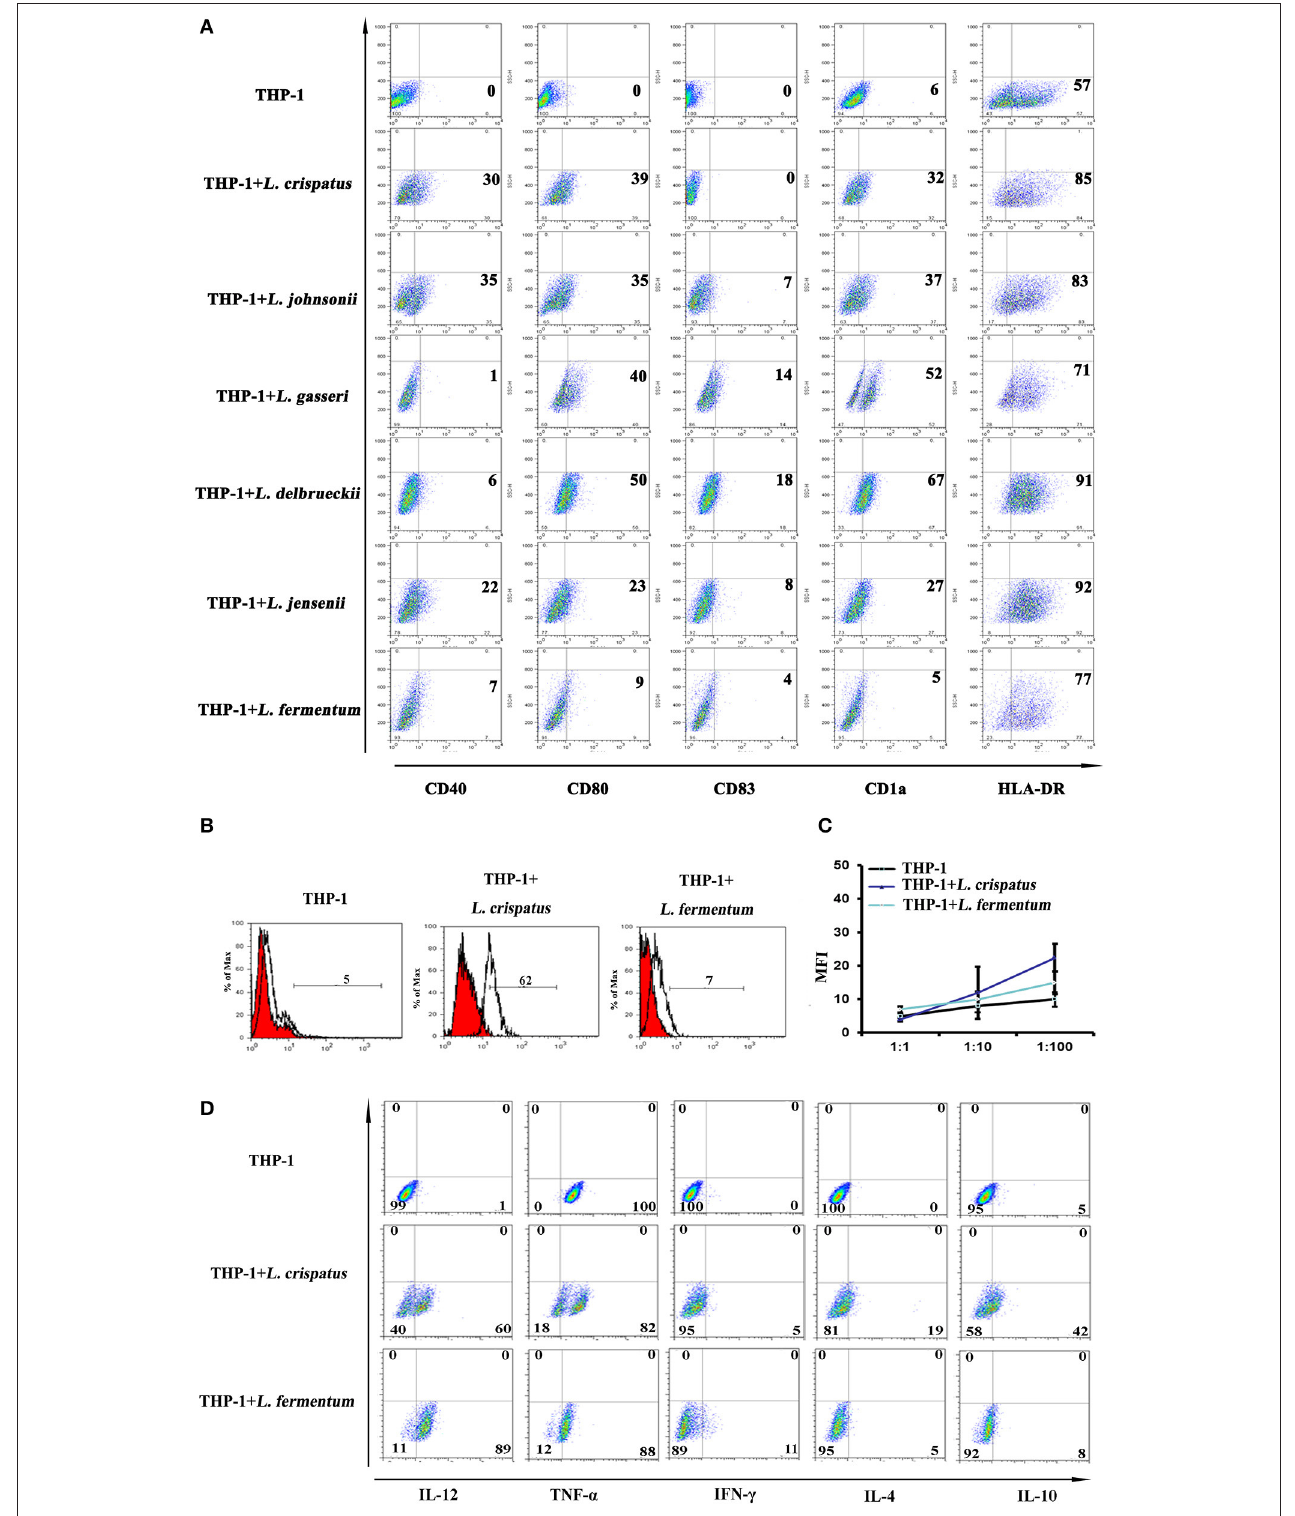
FIGURE 2 | Dendritic cell characteristics on THP-1 after co-culture with lactobacilli. (A) Flow cytometric results showed CD40, CD80, CD1a, CD83, and HLA-DR expression on THP-1 cells stimulated with different species of Lactobacillus ( L. crispatus, L. fermentum, L. jensenii, L. gasseri, L. delbrueckii 1, and L. johnsonii ) compared with unstimulated THP-1 cells. The percentages of positive cells in each analysis measured by MFI (mean fluorescence intensity) are presented.